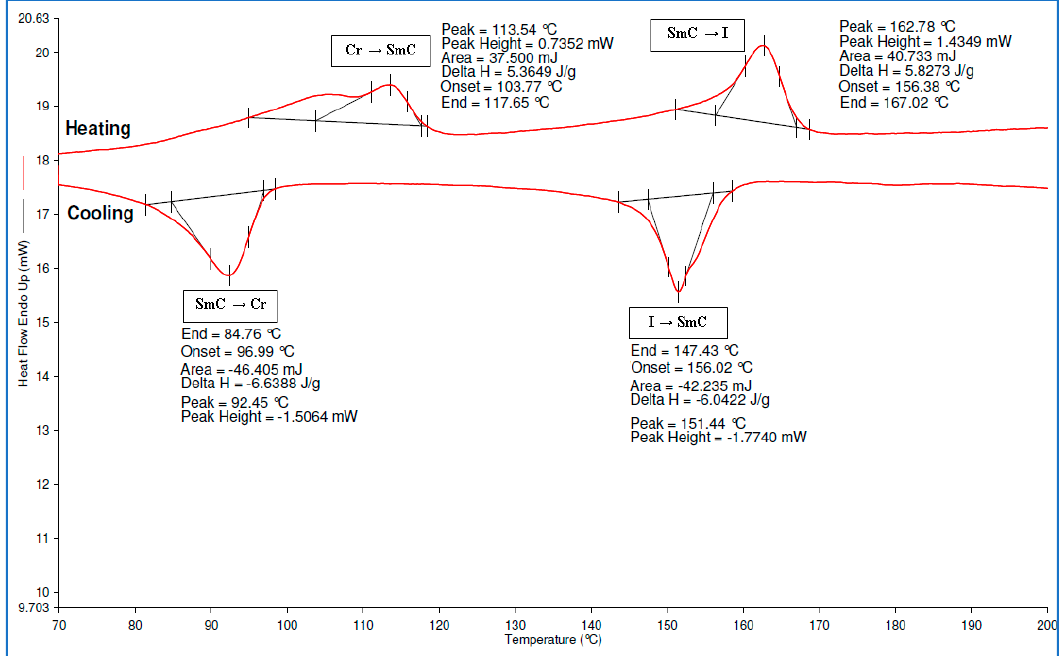
Figure 16. DSC thermogram of compound 8c .